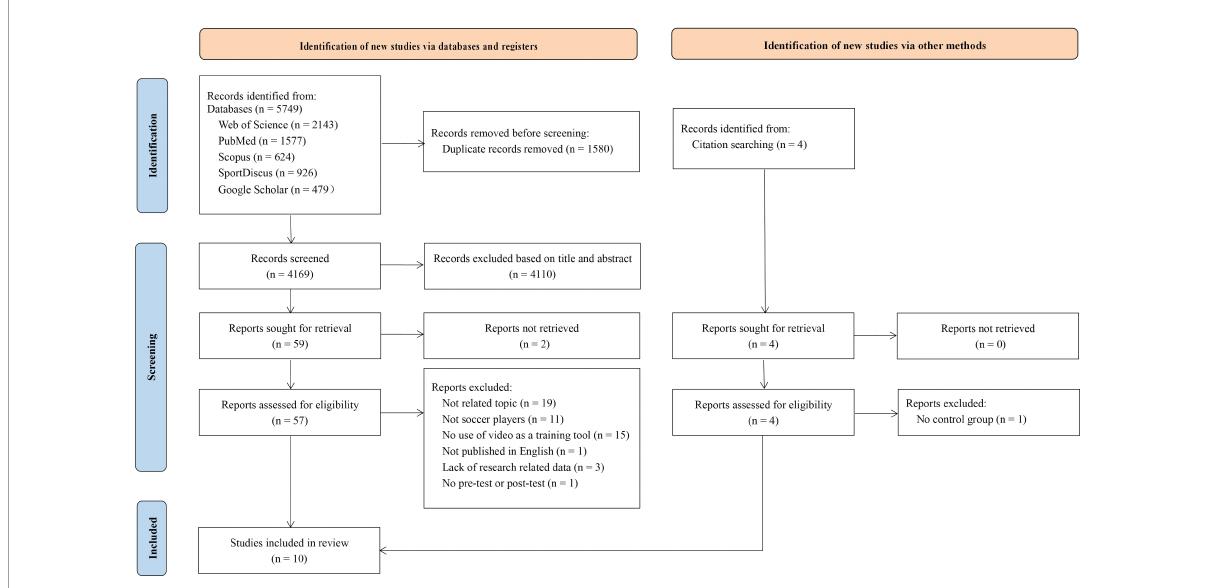
FIGURE1 Flowchart of search and study selection according to PRISMA